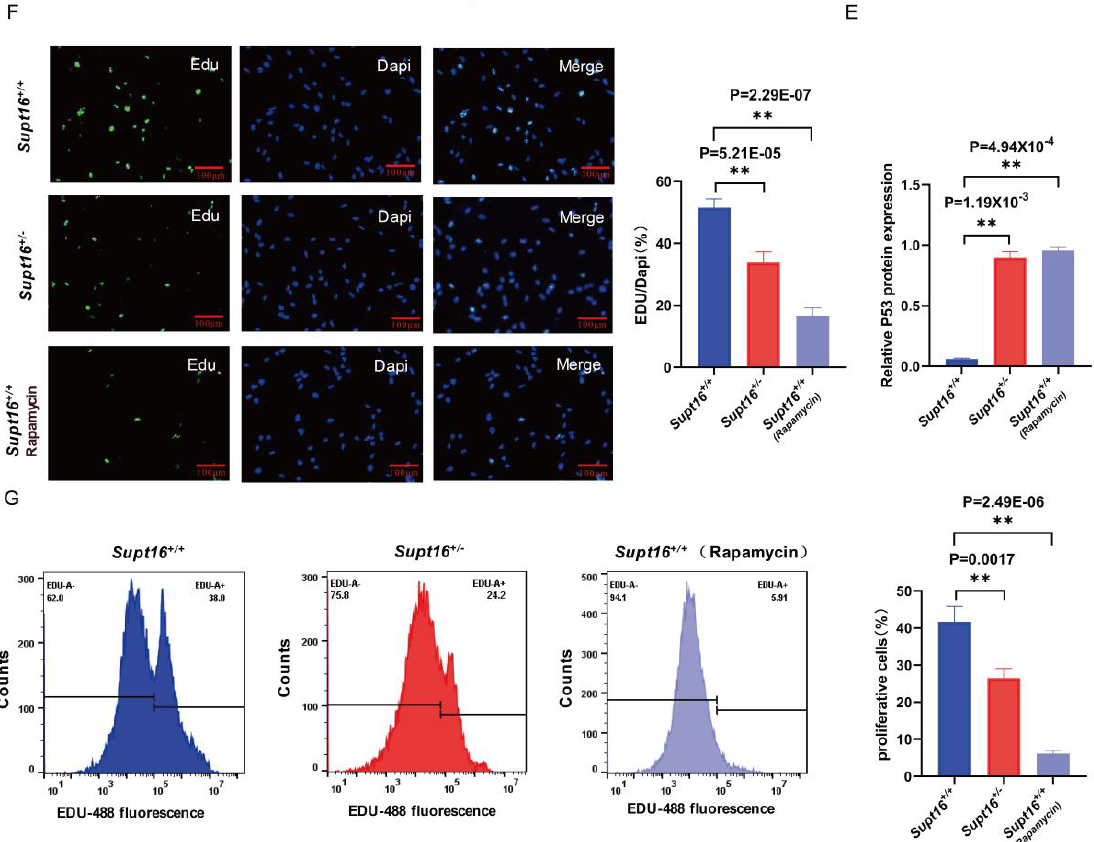
Figure 3. Wild − type hNSCs treated by rapamycin reproduced the phenotype of Supt16 haploinsufficient hNSCs . ( A ) Western blot analysis showing P − mTOR, LC3, PAX6, SOX2, and P53 protein expression in hNSCs treated with different treatments ( n = 3). ( B ) Quantification analysis of P − mTOR, LC3I protein relative to GAPDH. Data are means ± standard deviation of three independent experiments. ( C ) Quantification analysis of LC3II and LC3II/LC3I protein relative to GAPDH. Data are means ± standard deviation of three independent experiments. ( D ) Quantification analysis of PAX6 and SOX2 proteins relative to GAPDH. Data are means ± standard deviation of three independent experiments. ( E ) Quantification of P53 protein relative to GAPDH. Data are means ± standard devia- tion of three independent experiments. ( F ) Immunofluorescence staining showed that the absence of Supt16 in hNSCs suppressed the proliferation. Rapamycin treatment reproduced the inhibitory effect of Supt16 haploinsufficiency on the proliferation of hNSCs. ( G ) Cell cycle analysis using PI staining in WT, Supt16 heterozygous and rapamycin-treated WT hNSCs ( n = 3). The different cell cycle phases were calculated in FlowJo (v10.4.0). The error bars represented the mean ± SD and the significance level was calculated by Student’s t-test (two-tailed, equal variance) (ns means not statistically significant, * p < 0.05, ** p <